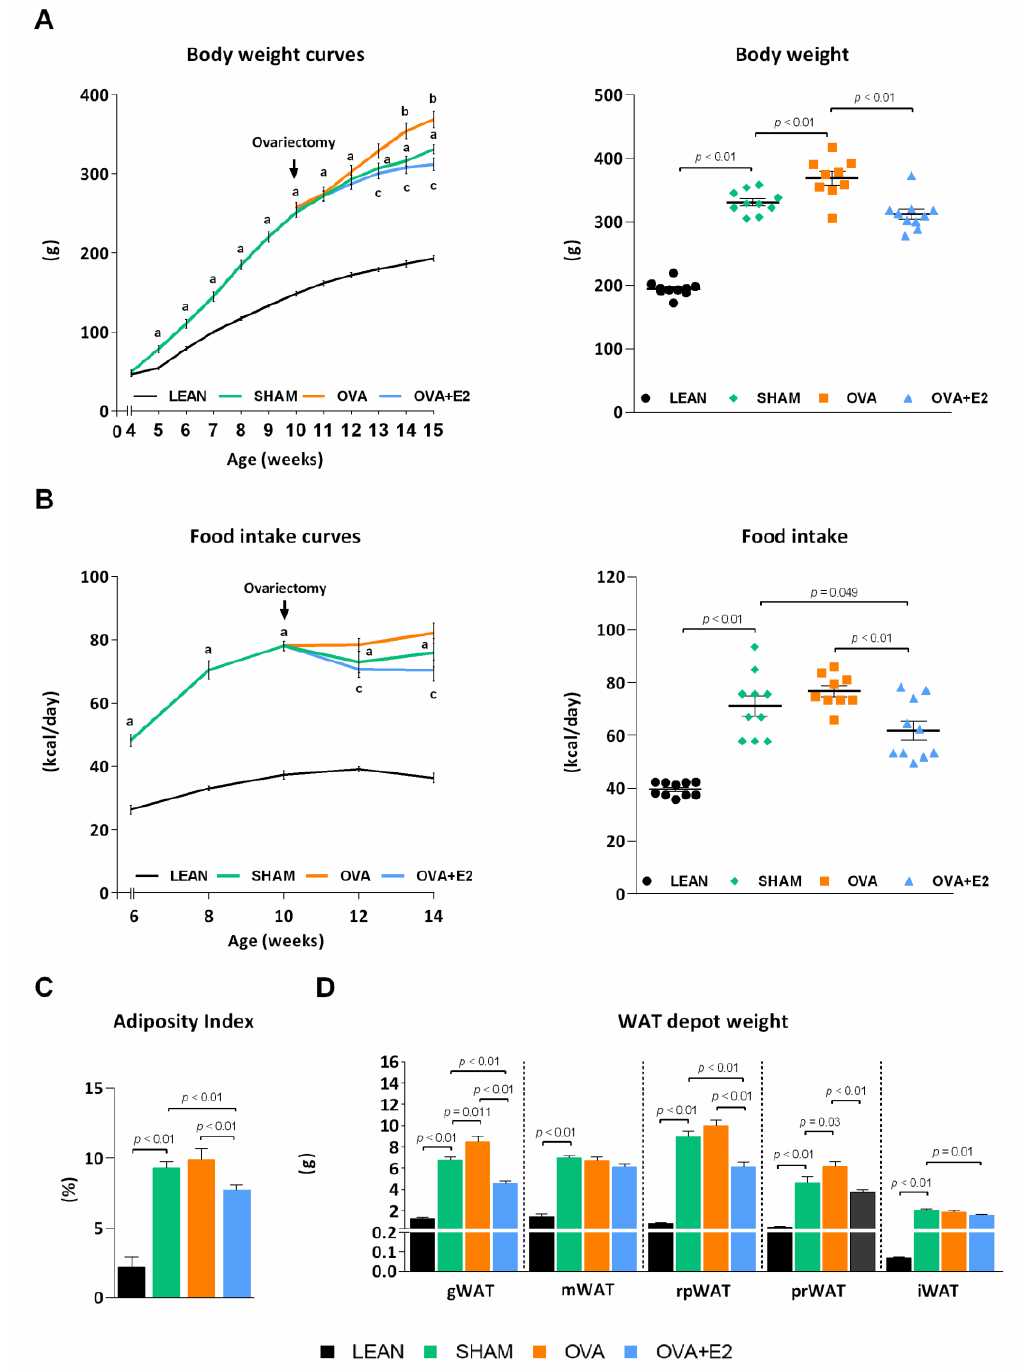
Figure 1. Ovariectomy and E2 treatment effects on body weight, food intake and adiposity in female ZDF rats. ( A ) Body weight and ( B ) food intake over the time (left panels) and at termination of the study (right panels). In A and B the arrow indicates the moment of ovariectomy and the start of E2 or vehicle treatment. ( C ) The Adiposity index corresponds to the sum of all adipose depots weight referred to 100 g of body weight. ( D ) WAT depot weight. WAT, white adipose tissue; gWAT, gonadal WAT; mWAT, mesenteric WAT; rpWAT, retroperitoneal WAT; prWAT, perirenal WAT; iWAT, inguinal WAT; E2, 17 β -estradiol. Values are expressed as the mean ± SEM. Differences between obese-diabetic (SHAM) and control (LEAN) animals were analyzed by Student’s t -test. Differences between obese-diabetic groups with different hormonal manipulation were analyzed by One-way ANOVA with Fisher’s LSD post-hoc test. Student’s t -test: a, SHAM vs. LEAN. One-way ANOVA: b, OVA or OVA + E2 vs. SHAM; c, OVA + E2 vs. OVA.